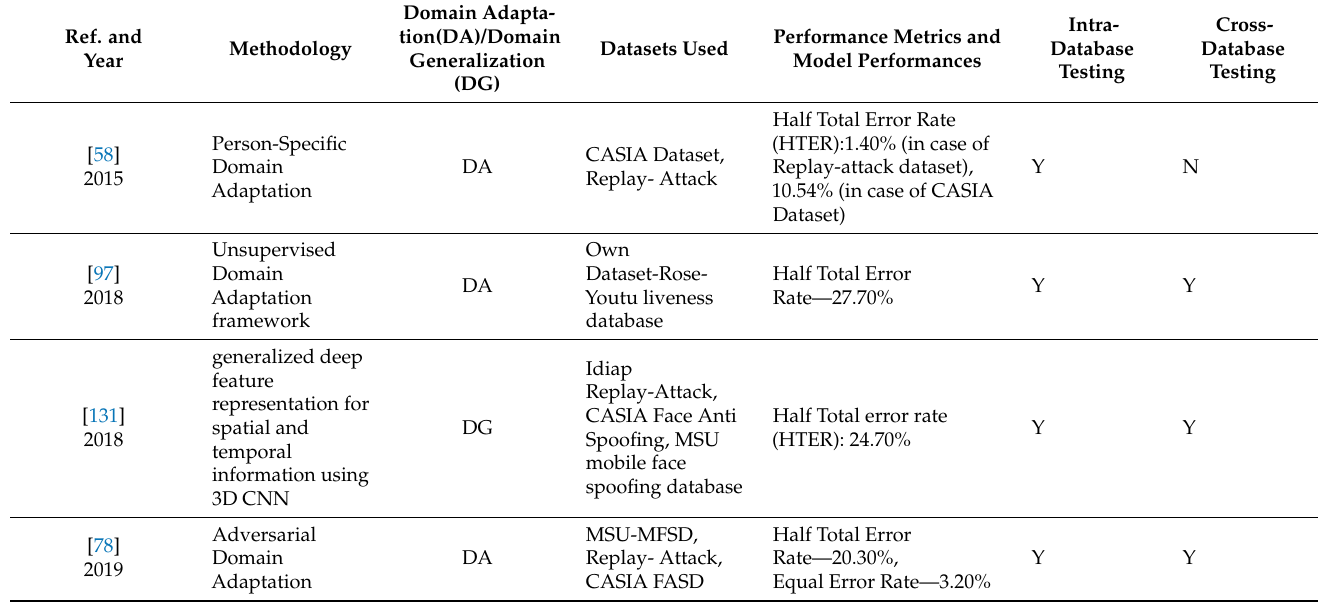
Table 9. Few popular methodologies are used in Face Liveness